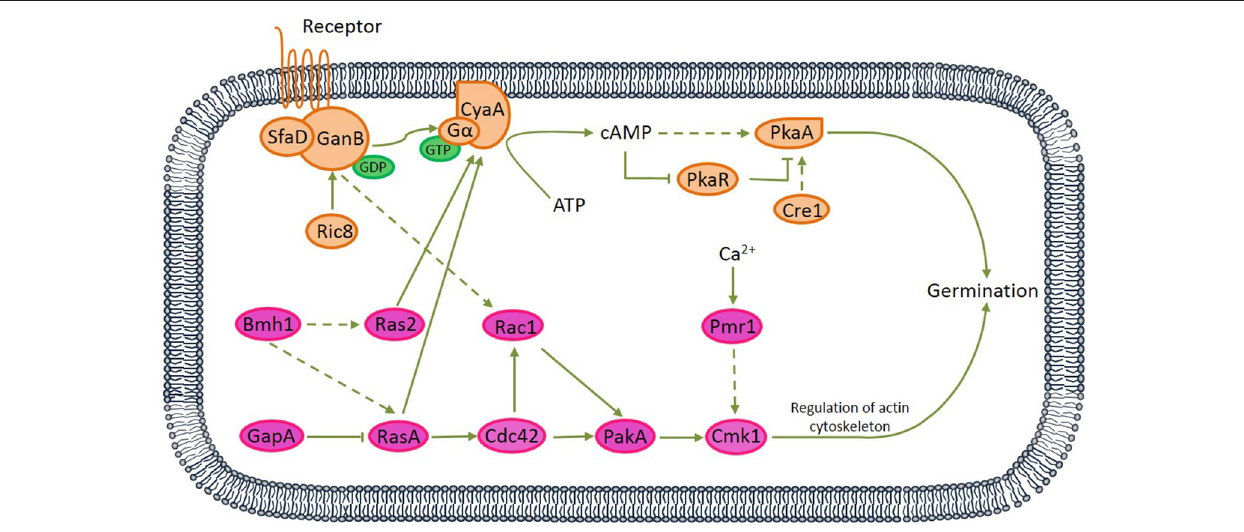
FIGURE 3 | Proposed protein kinase A (PKA) and mitogen-activated protein kinase (MAPK) signaling pathways relating to the germination of A . camphorata arthroconidia. Both G protein-coupled receptor (seven transmembrane receptor) and non-receptor RIC8 (guanine nucleotide exchange factor) might be capable of activating GanB( α )-SfaD( β ) dimer, thereby might lead to GDP-GTP exchange on the G α protein. Active G α -GTP further might trigger cAMP/PKA signaling by separating from CyaA subunit and activating adenylate cyclase, which might be responsible for cAMP synthesis. cAMP binding to the regulatory subunit of PKA might cause its dissociation from the catalytic subunit